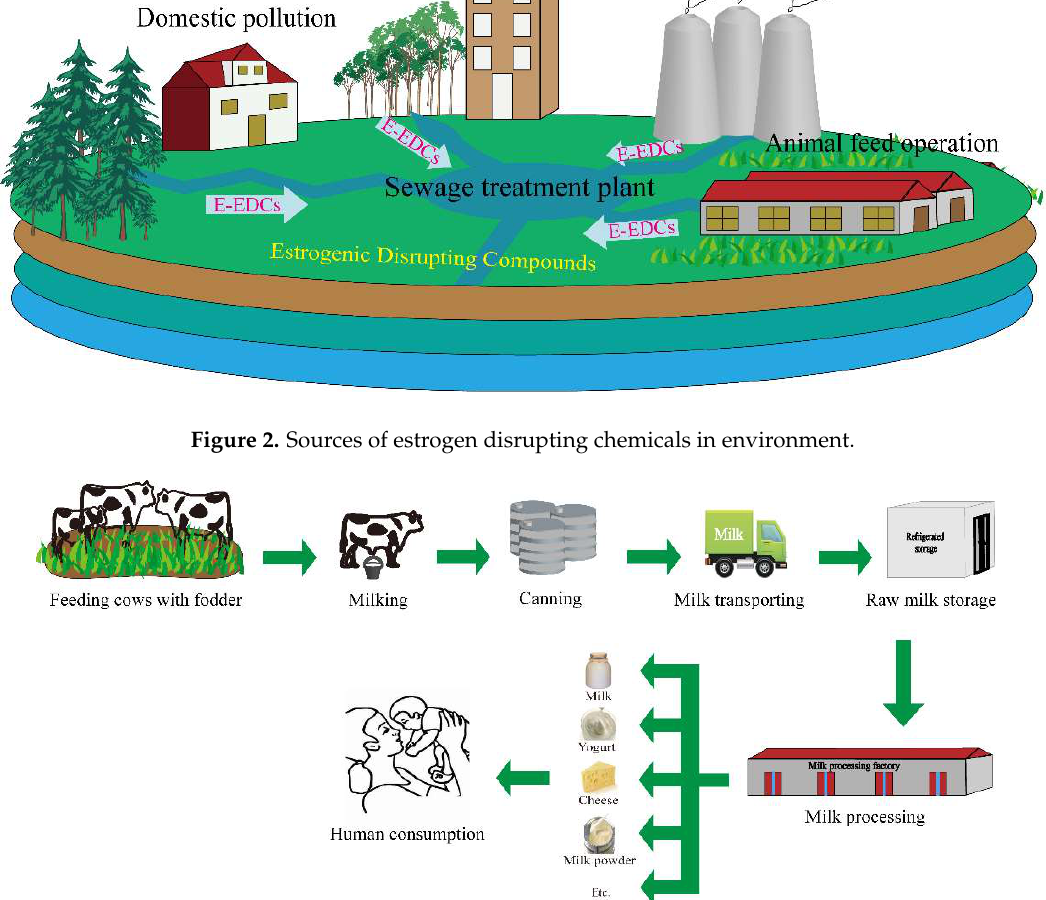
Figure 3. Sources of BPA in milk and dairy products.